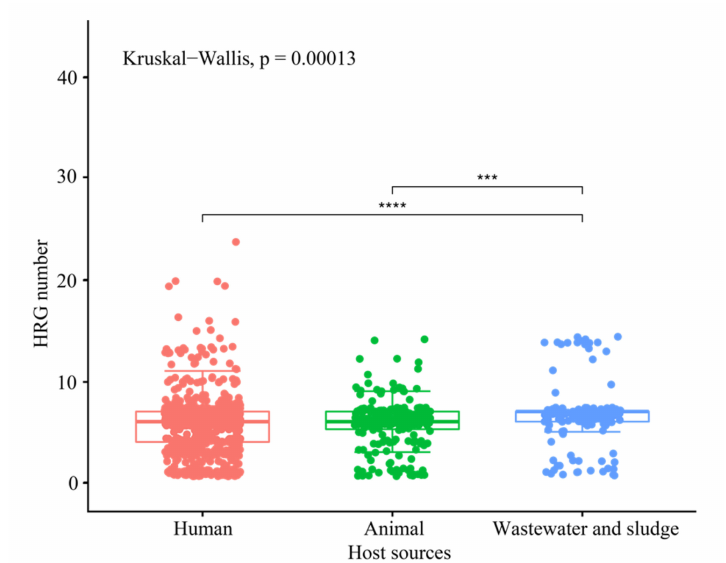
Figure 2. Number of HRGs per plasmid by the host source, showing that the host source impacts the distribution of HRGs in plasmids. *** p < 0.001 and **** p < 0.0001 based on Wilcoxon rank-sum test after a significant Kruskal–Wallis.